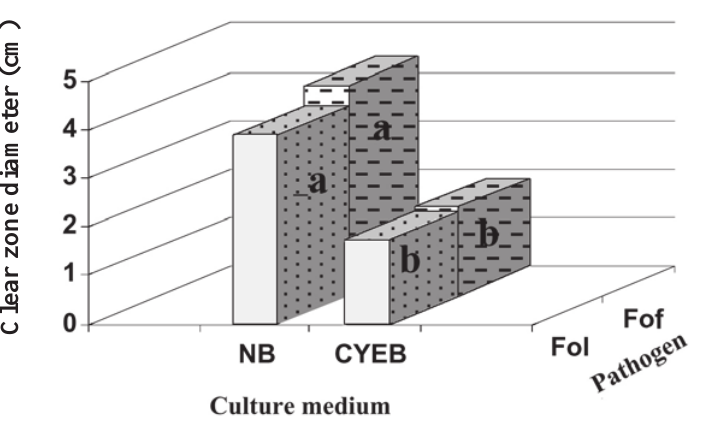
Fig. 3. Effect of the culture medium on the activity of the biocontrol agent (expressed as clear zone diameter). LSD=0.4442. Means with the same letters are not significantly different ( P =0.05). NB, Nutrient broth, CYEB, Czapek’s yeast extract broth; Fof, Fusarium oxysporum f. sp. fabae . Fol, Fusarium oxysporum f. sp. lupini